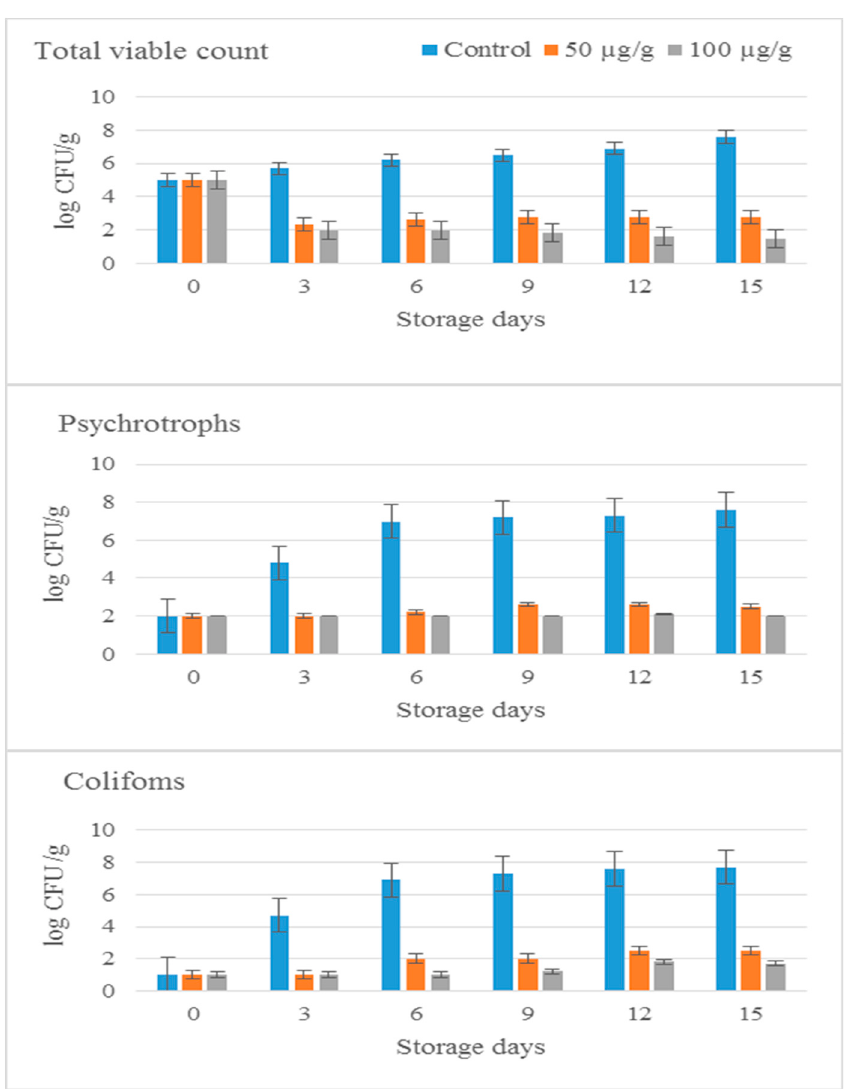
Figure 4. Total viable count, psychotrophs count and coliform count in minced beef treated with 11S globulin at different concentrations (50 and 100 µg/g) and stored at 4 °C for different periods (0–15 day) compared to the control.